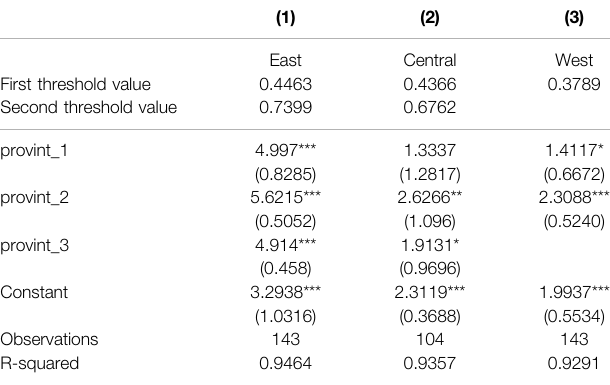
TABLE 8 | Regression results of threshold models in the east, central and west